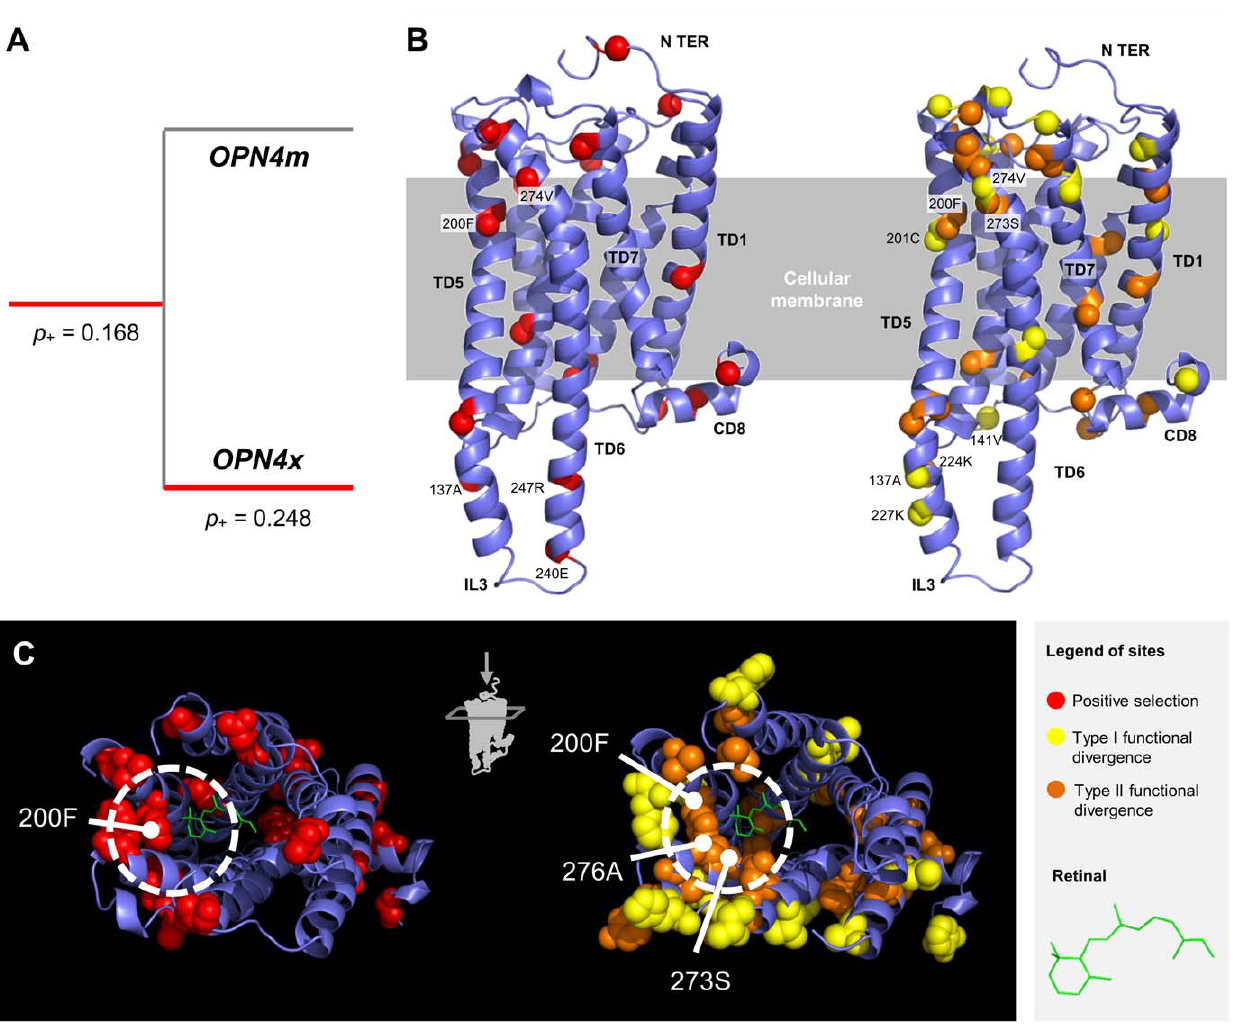
Figure 4. Branch and site selective pressures during the OPN4m/OPN4x duplication event. A. Branch-site tests. Red lineages represent an inferred episode of positive selection. In those branches is represented the p + parameter (proportion of the positively selected sites). B. Representation of the positively selected and functional divergence sites (type I in yellow and type II in orange) in the three-dimensional structure of the Gallus gallus OPN4m protein. C. A detailed perspective of the retinal accommodation on the melanopsin molecule and the occurrence of the positively selected and type I and II functional divergence sites.